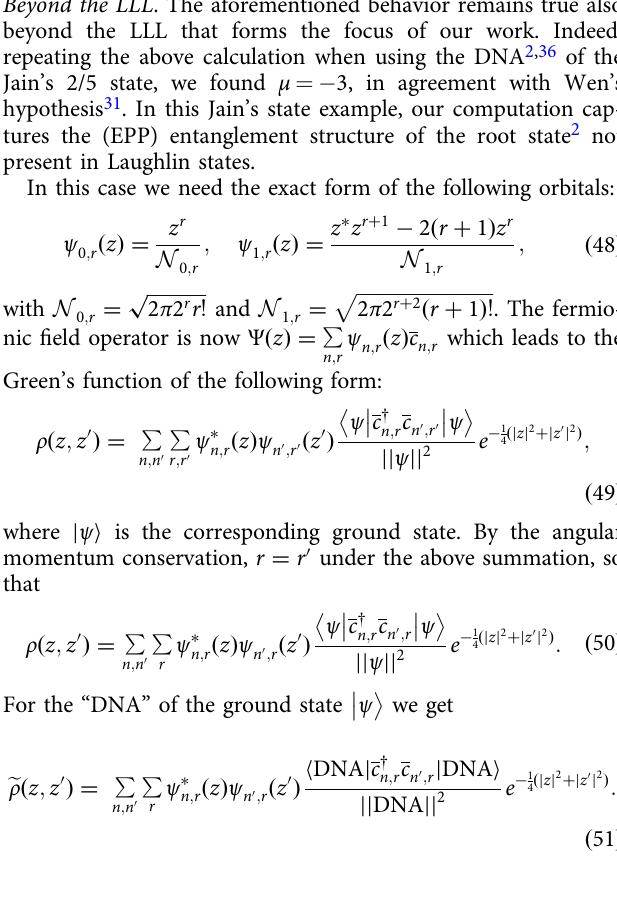
N = 8 and the range [0.6, 1] we obtain μ = − 3.23 (for linear scale